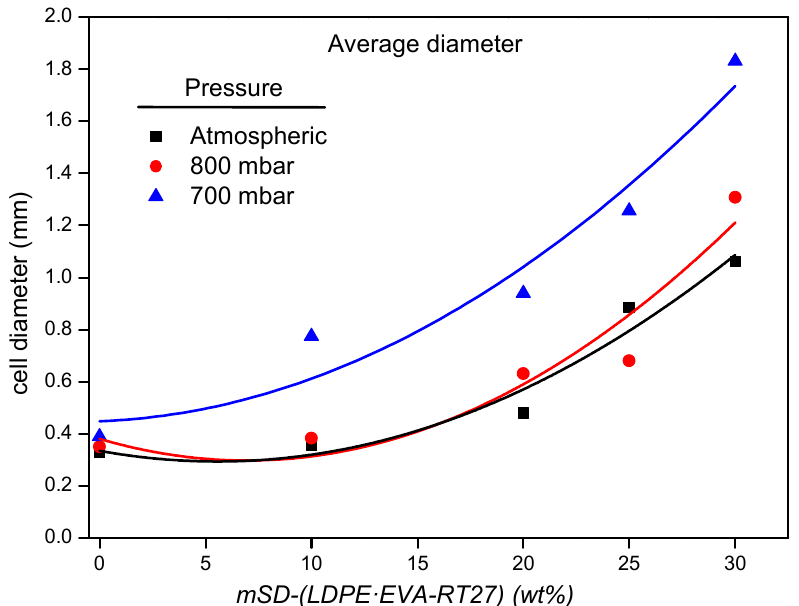
Figure 7. Average cell diameter of the obtained foams for the different operational pressures.